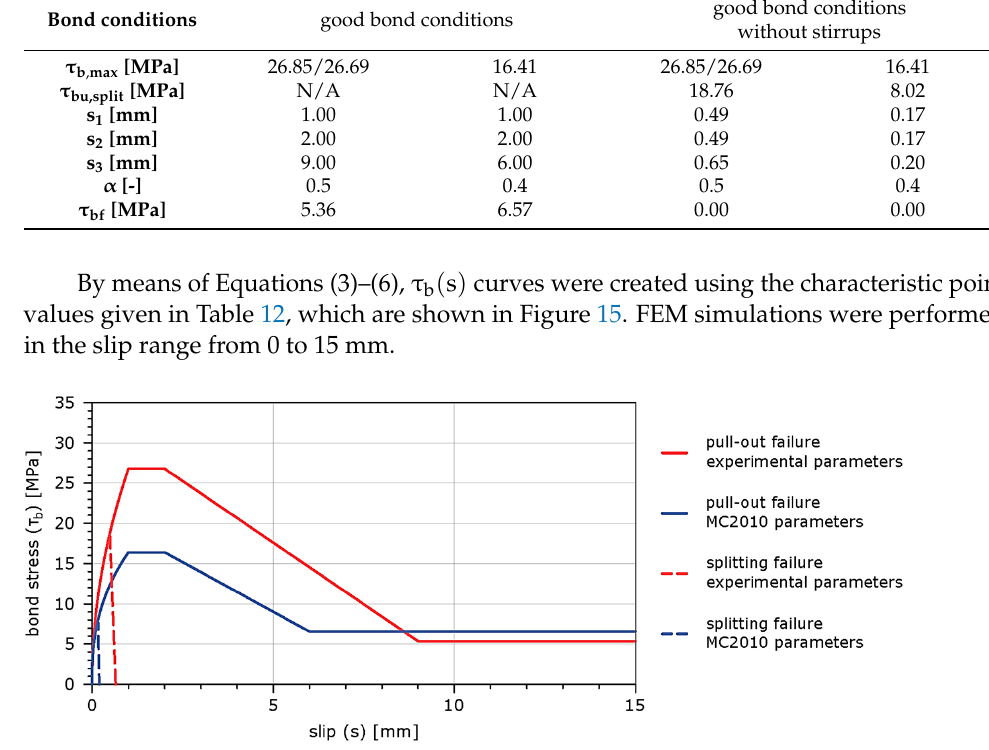
Figure 15. Bond model acc. MC2010 [4] for characteristic points obtained from experiments and from